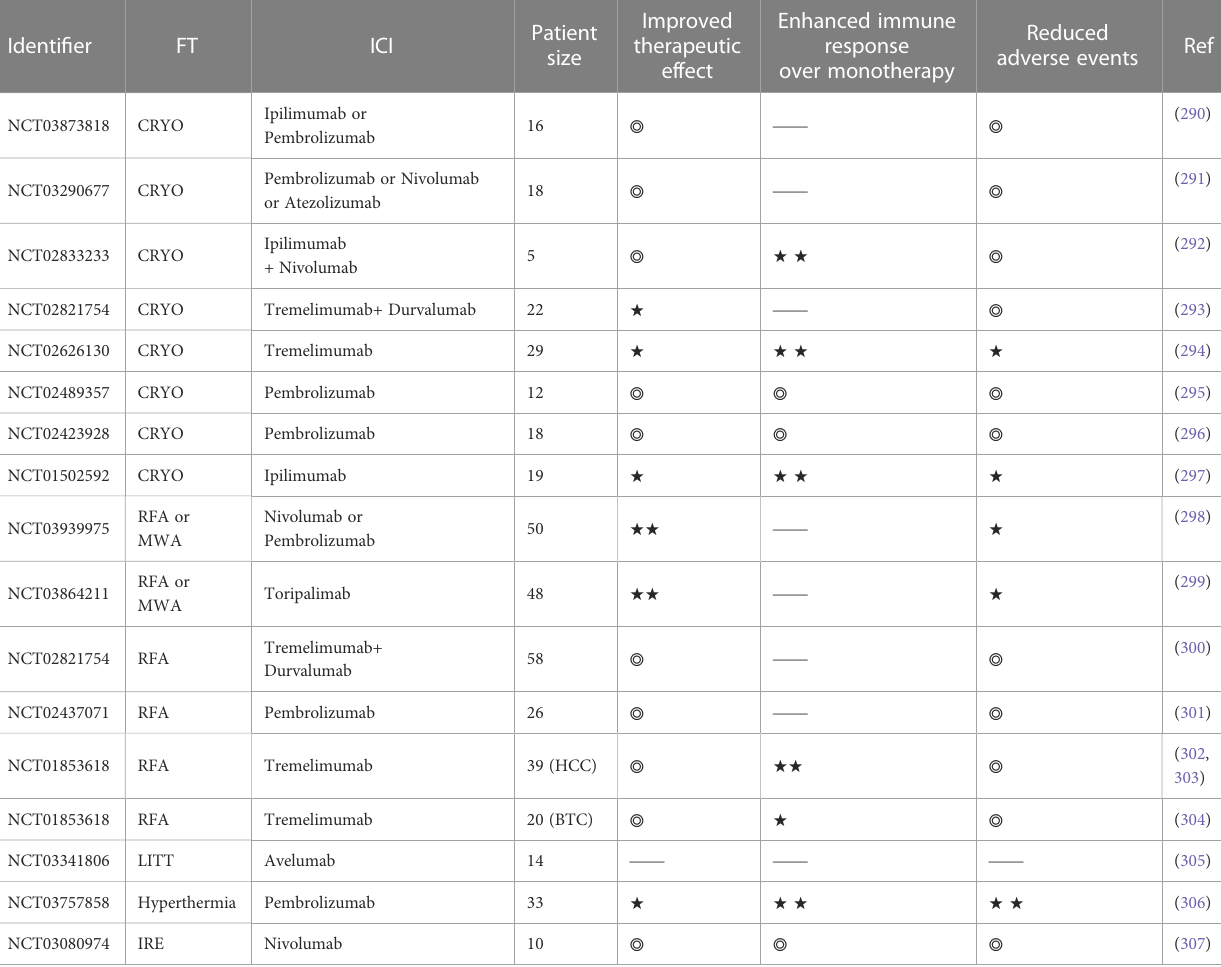
TABLE 11 Clinical report summary. ★ ★ : good, ★ : marginal, ◎ : No comparison, ― : No data.